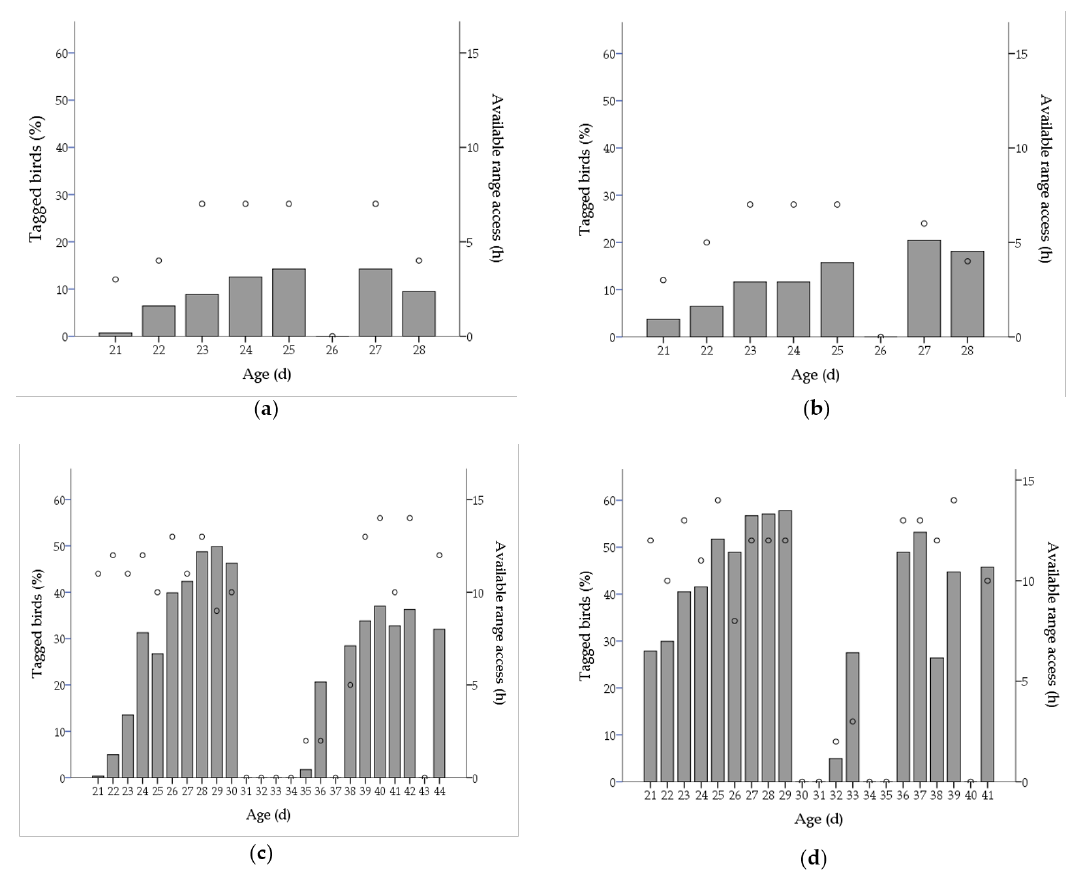
Figure 2. Bars indicate the proportion of chickens that accessed the range (%successfully tracked chickens; left y-axis) daily in winter ( a ) flock A ( b ) flock B and summer ( c ) flock C ( d ) flock D. Circles indicate time (hours; right y-axis) the range was available each day.